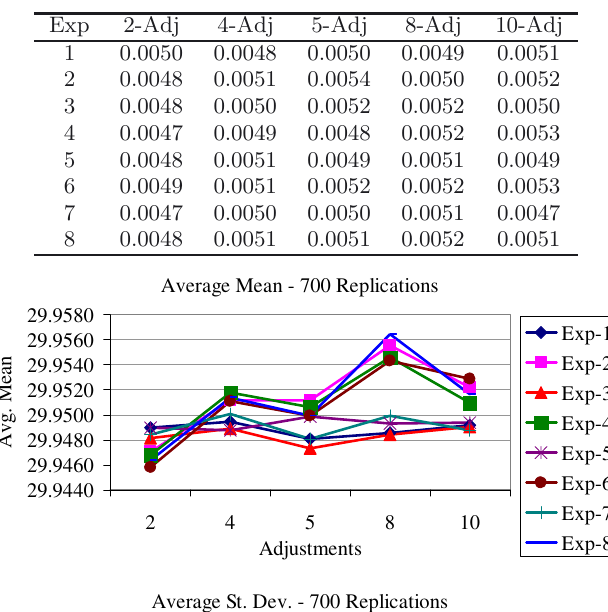
Table 6. St. Dev. of the average standard deviation values σ assy , adj .